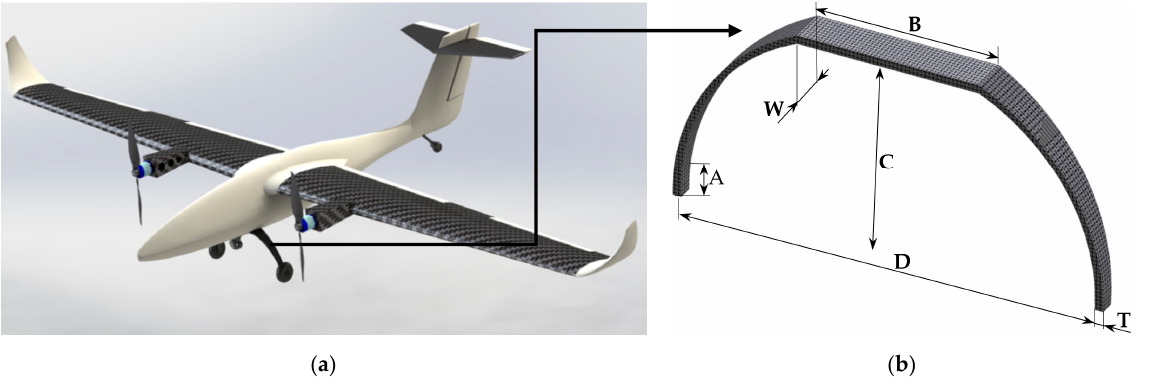
Figure 1. Landing gear: ( a ) position on the UAV; ( b ) dimensions.